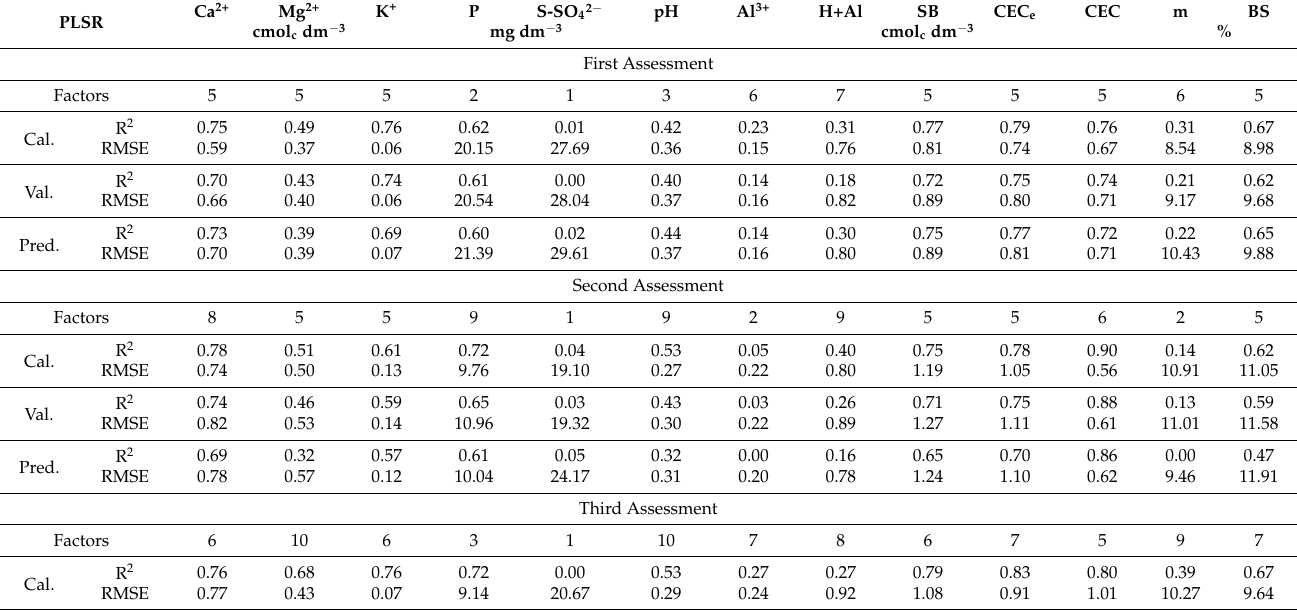
Table A1. Statistical parameters of the PLSR models developed from the four soil assessments (without iPLS